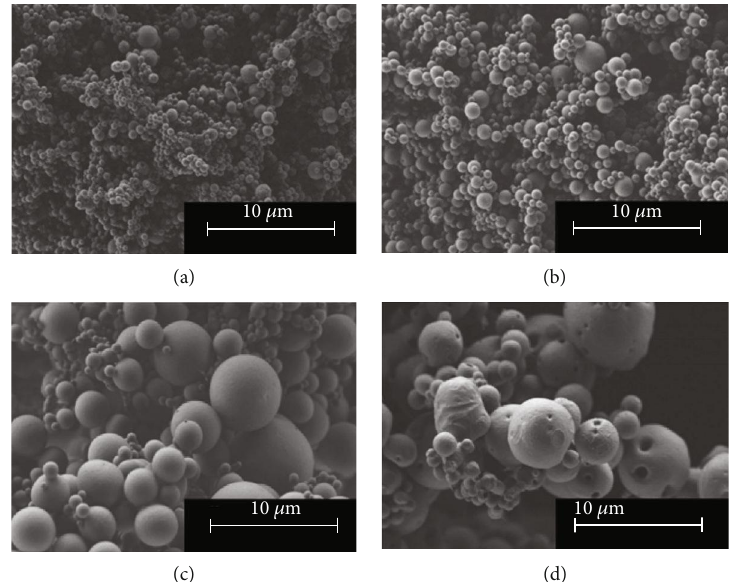
Figure 11: FE-SEM images of the eugenol-loaded CA (a), CAB (b), CAP (c), and EC (d) microspheres produced at smaller scale (1500 × magni fi cation)